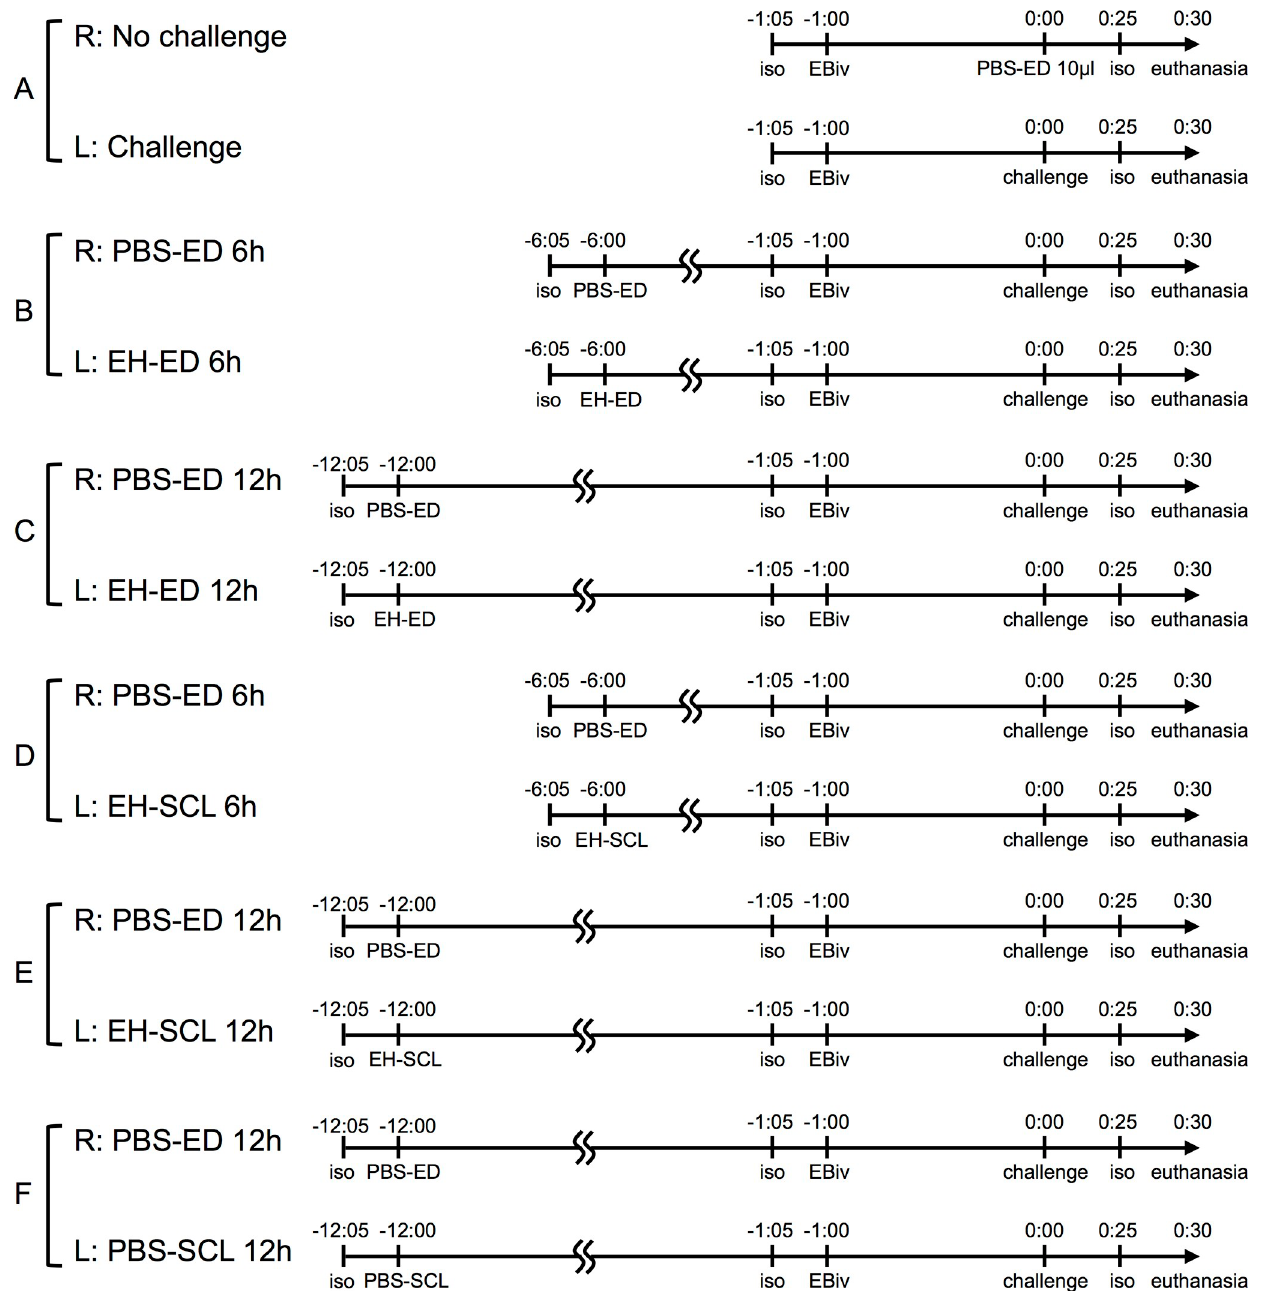
Fig 1. Schedule of the in vivo study. Scheduled procedures were undertaken in the 5 groups, A-E, of 6 guinea pigs each, and a group of 3 guinea pigs, F. iso: anesthesia by isoflurane inhalation, EBiv: intravenous injection of Evans blue, PBS-ED: instillation of eye drops of 50 μ L of phosphate buffered saline, EH-ED: instillation of eye drops of 50 μ L of a 0.05% (w/v) solution of epinastine hydrochloride in phosphate buffered saline. PBS-SCL: insertion of a soft contact lens containing no epinastine hydrochloride, EH-SCL: insertion of a soft contact lens containing epinastine hydrochloride, challenge: instillation of eye drops of 10 μ L of a 1% (w/v) solution of histamine in phosphate-buffered saline (soft contact lenses were removed just before the challenge), euthanasia: decapitation under deep anesthesia with isoflurane inhalation.